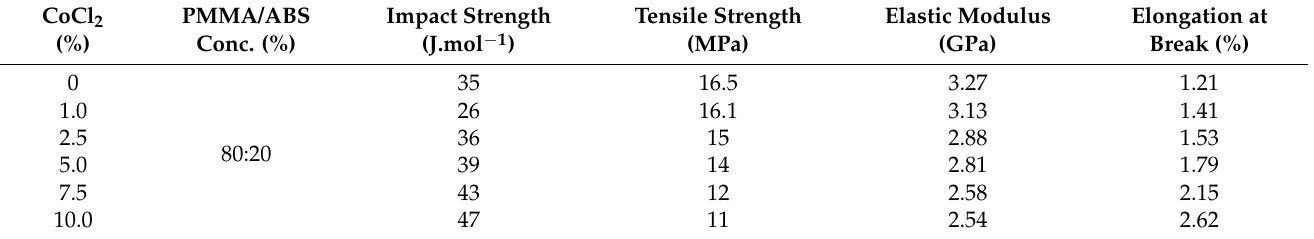
Table 1. Mechanical properties of the PMMA/ABS blend with different contents of cobalt chloride.